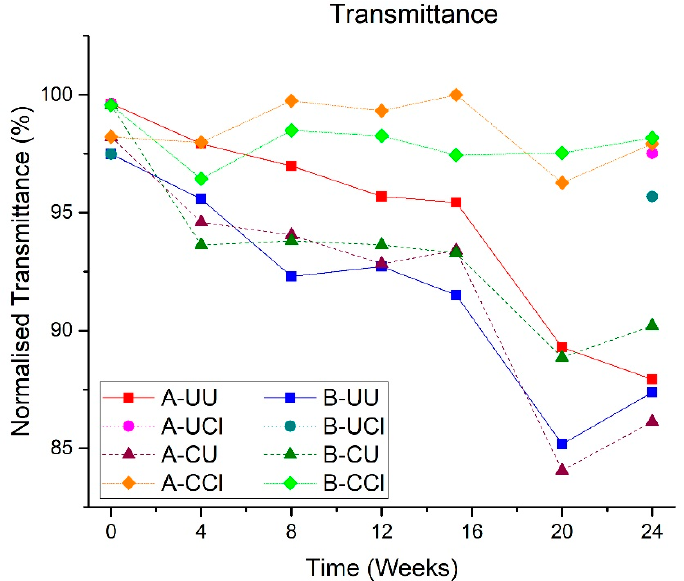
function of outdoor exposure time. Abbreviations: UU—Uncoated uncleaned, UCl—Uncoated